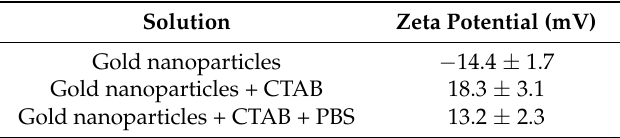
Table 2. Zeta potential values with gold nanoparticles in different solutions.